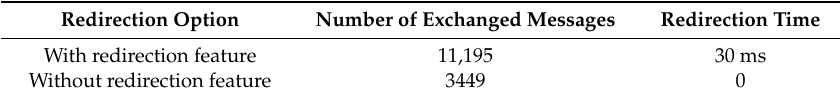
Table 5. Redirection